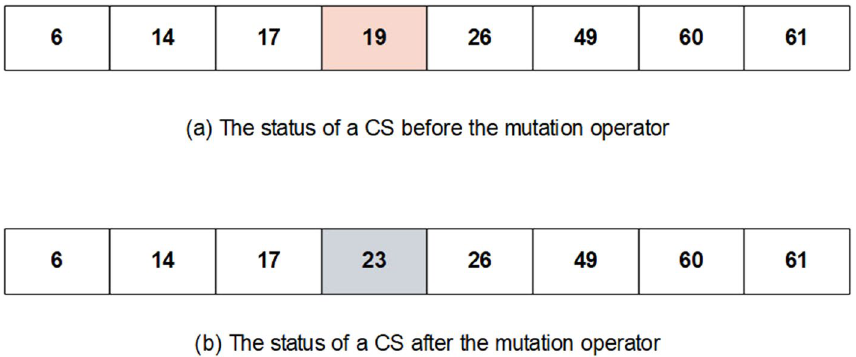
Figure 3. An example of the utilized mutation operator, which choses a variable randomly and changes its value. ( a ) The status of a CS has been shown before applying the operator. ( b ) The status of a CS has been shown after applying the operator. CS, candidate solution.